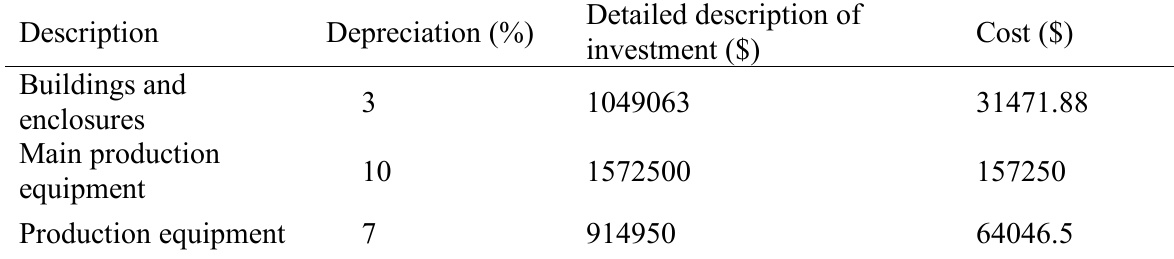
Table 13. Annual depreciation costs of fixed